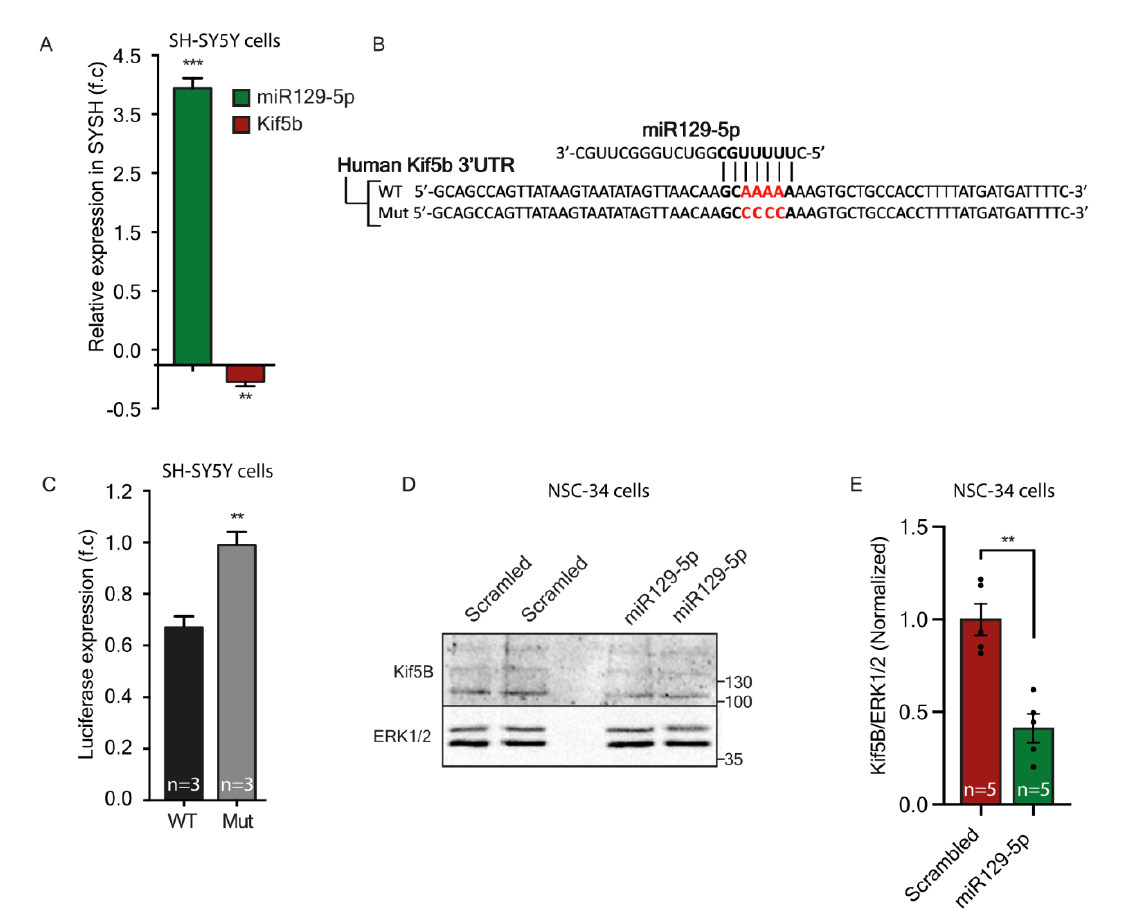
Figure 5. miR-129-5p targets Kif5b mRNA and regulates Kif5b protein levels. ( A ) Real-time PCR analysis of normalized miR-129-5p and Kif5b mRNA expression following 24 h of miRNA overexpression (OE) in the SH-S5Y5 neuroblastoma cell line, relative to control plasmid OE. Unpaired students’ t-test. ** p < 0.01, *** p < 0.0001. ( B ) Sequences of Renilla/Firefly luciferase under the regulation of Kif5b 3′ UTRs that were used for transient reporter assay experiments. Wild-type (WT) and mutant (mut) alleles for miR-129-5p binding sites are presented. The miRNA seed region and complimentary 3 ’ UTR sequence are marked in bold. Mutagenic nucleotides are marked in red and bold. ( C ) Luciferase activity 48 h following co-transfection of miR-129-5p with Renilla/Firefly luciferase constructs under the regulation of Kif5b 3′ UTR. The graph shows the relative expression level of Firefly luciferase standardized to Renilla luciferase. The paired two-tail Student’s t-test was used for statistical analysis (n = 3, ** p < 0.01). ( D – E ) Western blot ( D ) and analysis of Kif5b protein (~110 kDa) levels in NSC-34 overexpressing miR-129-5p or scrambled control for 72 hours. ( E ). ERK1/2 (42–44 kDa) was used as a loading control. ** p < 0.01 student’s t-test, n = 5 independent